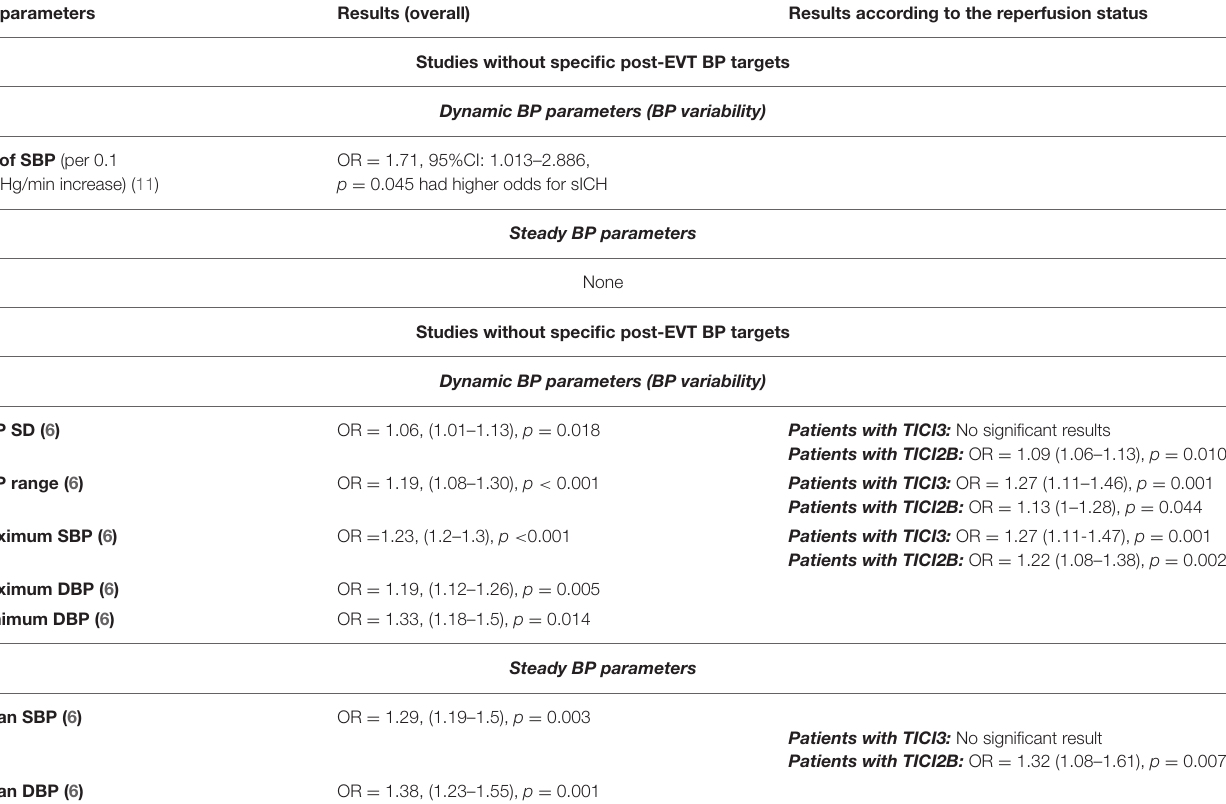
TABLE 3 | Blood pressure parameters associated with sICH in multivariate analysis, in the overall population and according to the specific reperfusion status. BP